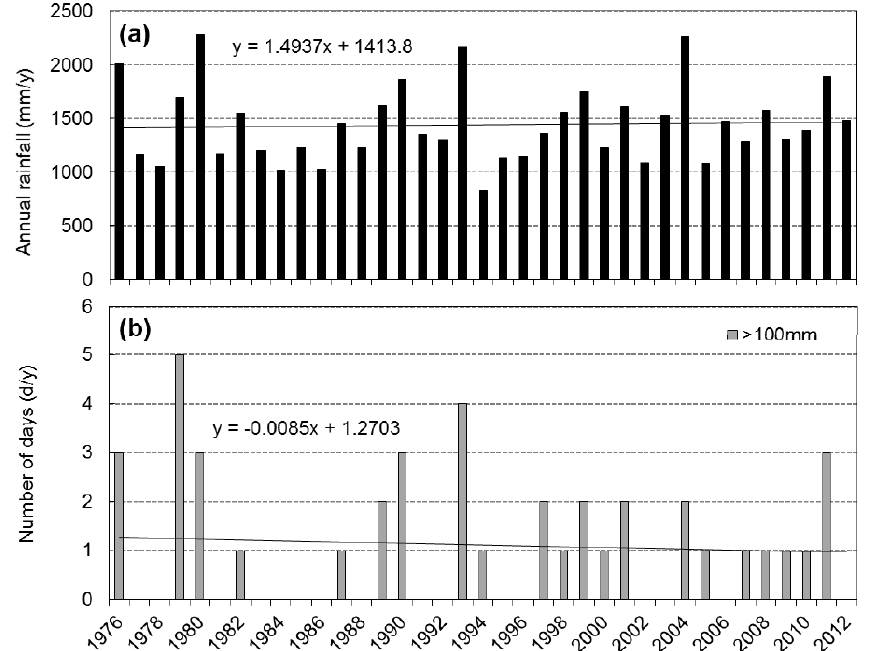
Figure 4. Variation of annual rainfall in the Saijo city from 1976–2012 (a) and number of days exceeded 100mm of daily rainfall (b) .